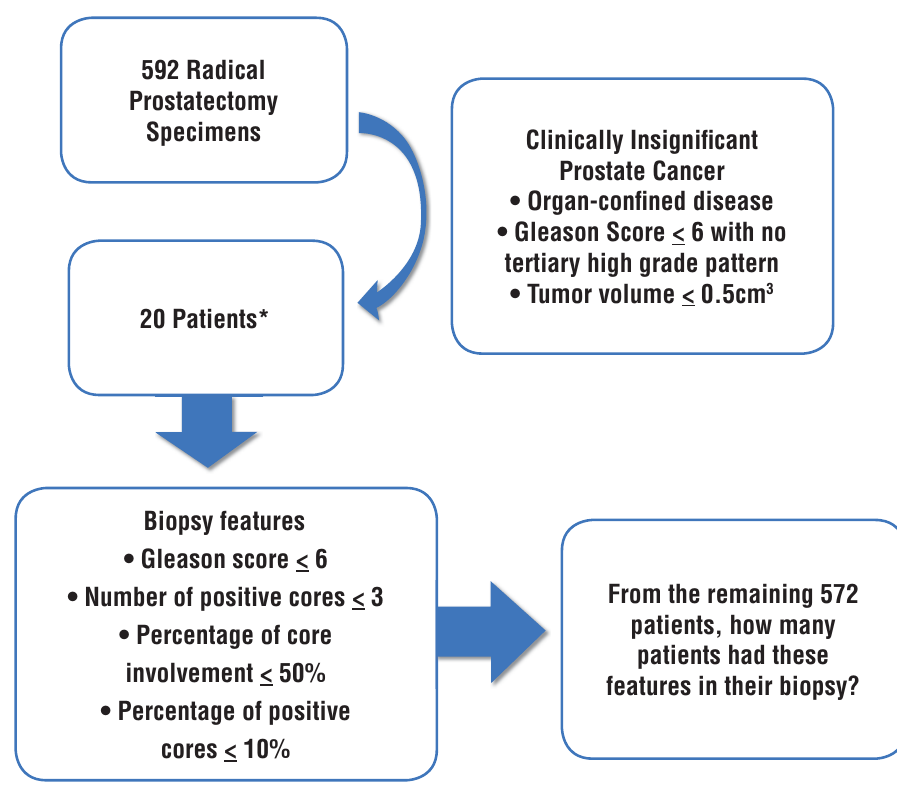
Figure 1 - Selection of patients who had clinically insignifi cant prostate cancer in radical prostatectomy as well as features of insignifi cant tumor in